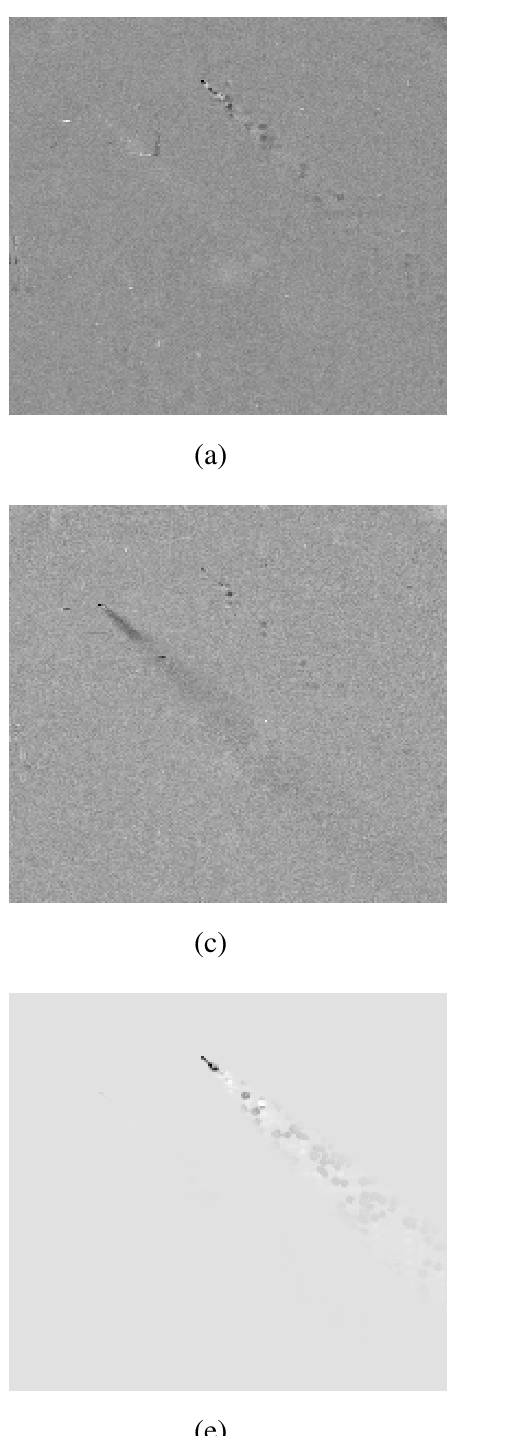
3 plume in Channel 58 (scene-wide 3 plume 3